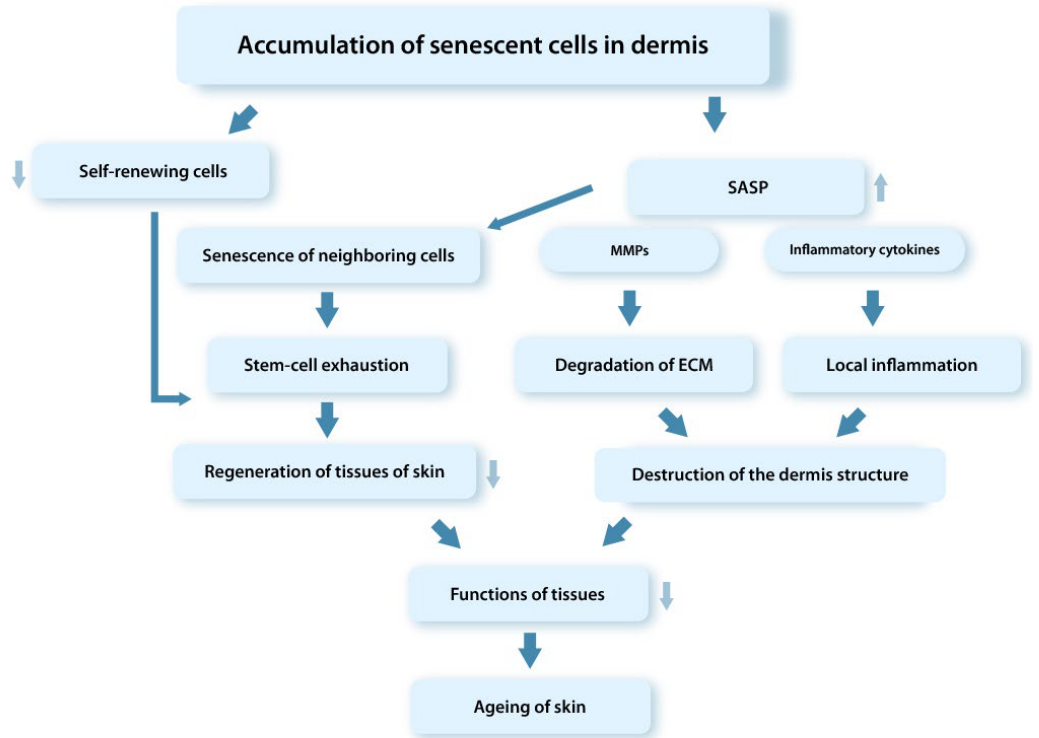
Figure 5. Schematic representation of mechanisms of the tissue dysfunction involving senCs (SASP). SenCs accumulating with age in tissues contribute through the SASP factors to the depletion of the SC pool, degradation of ECM in the dermis, development of the chronic aseptic inflammation in tissues, and disruption of the tissue regenerative potential.